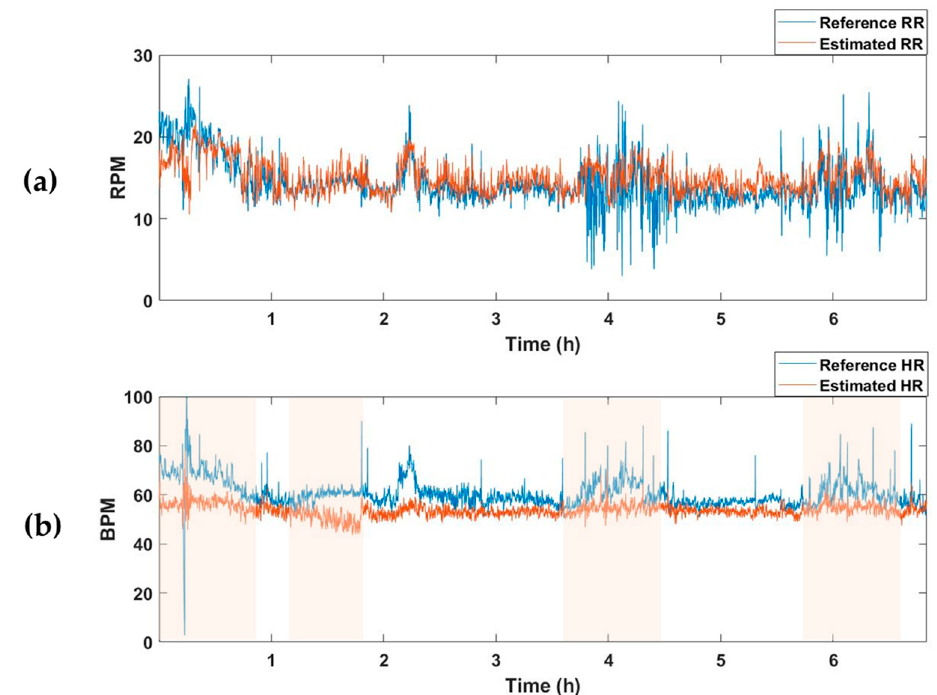
Figure 6. Vital-sign detection results obtained using the RR and HR estimation models. ( a ) Reference RR and estimated RR from RR predictor, and ( b ) reference HR and estimated HR from HR predictor. Pink shaded areas indicate the sections in which the MAE was larger than the HR estimated using the vital predictor in Figure 5. RPM, respiration per minute; BPM, beats per minute.